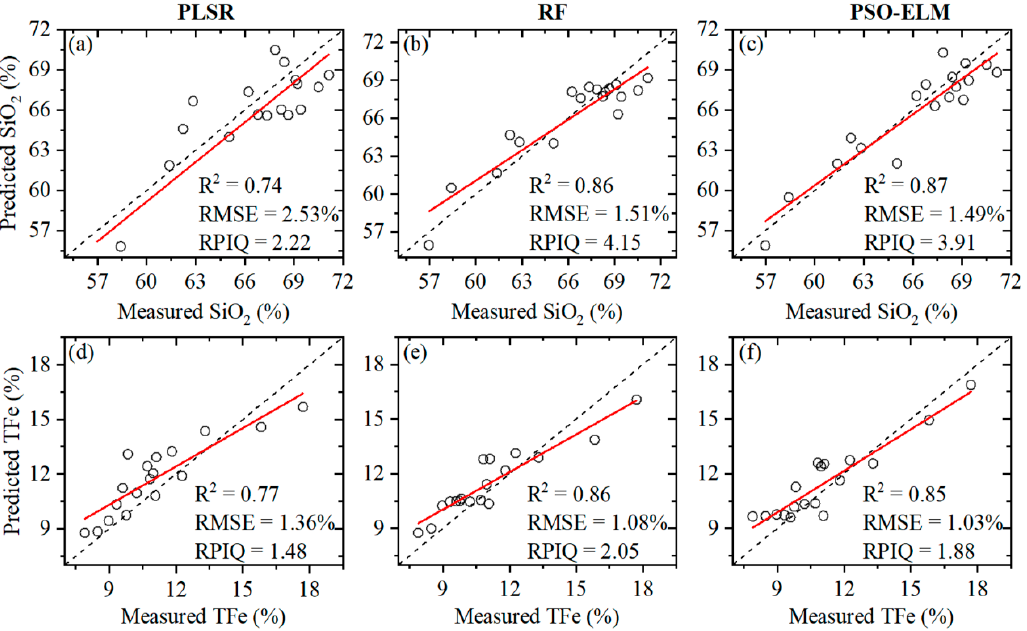
Figure 9. Validation between the measured and predicted value of SiO 2 ( a – c ) in the 1365–1391 nm and 1410–1623 nm range, TFe ( d – f ) in the 1163–2499 nm range from VIS–NIR using the PLSR, RF, and PSO–ELM models. The dashed line shows the 1:1 relationship and the red line shows the model trend.